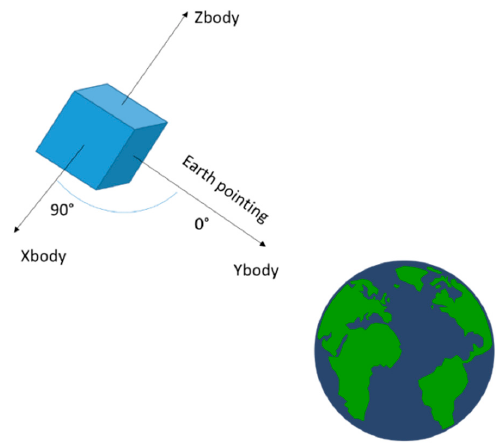
Figure 31. Earth-pointing attitude configuration assumed for the receiver.